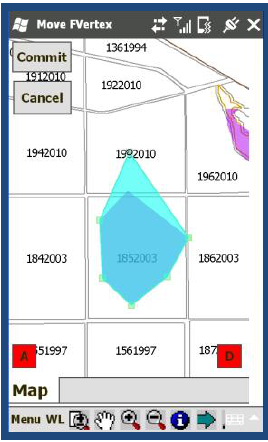
Figure 12. Posting data remotely to the